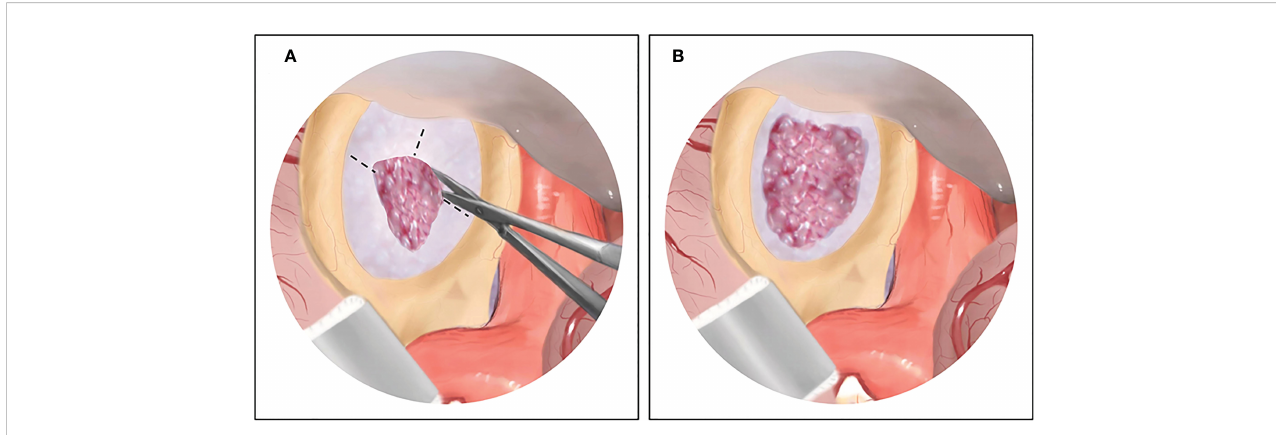
FIGURE 1 The illustration of surgical maneuvers of endoscopic transcranial transdiaphragmatic approach. (A) After complete excision of the suprasellar tumor by conventional transcranial surgery, the dilated diaphragma sellae is exposed, and then dissected anteriorly and laterally. (B) The diaphragma sellae is cut open and the residual tumor beneath the diaphragma sellae is clearly visible under endoscopic